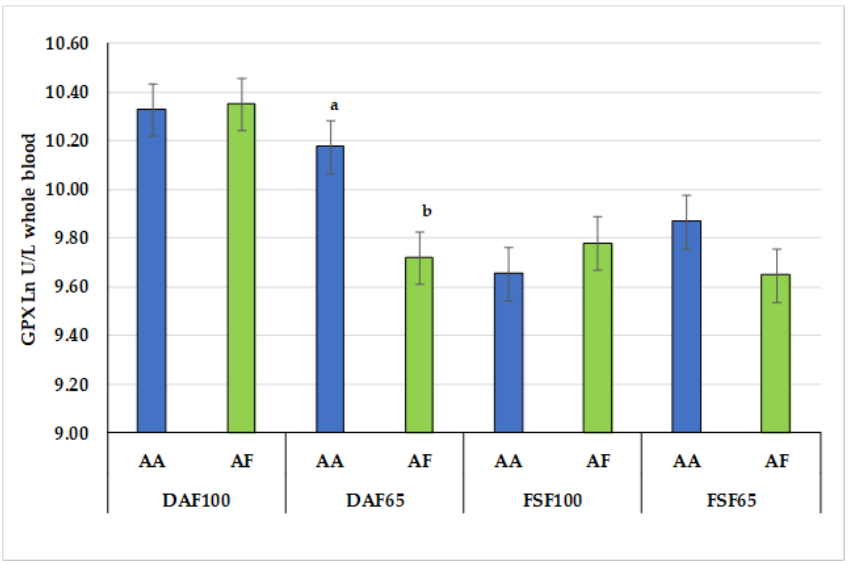
Figure 1. Interaction between genotype and diet for endogenous enzymatic antioxidant (GPX). Values within diets with different superscript letters are significantly different ( p < 0.05).